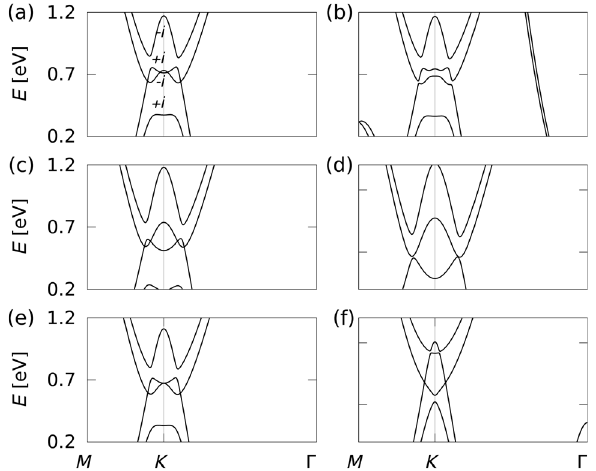
FIG. 10. (a) [(b)] Band structure of WC with [without] horizontal mirror symmetry. In the case with mirror symmetry, the mirror eigenvalues of the bands are given. (c) [(d)] Band structure of WC with tensile strain of 2% [5%] and (e) [(f)] with compressive strain of − 0 . 2% [ − 3% ] along the z